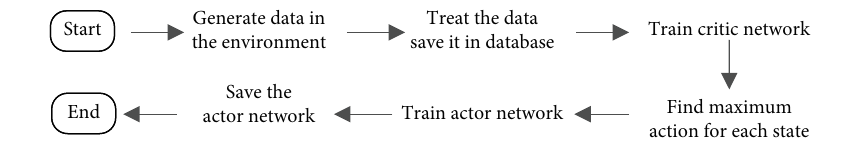
Figure 1: Open-loop training process.